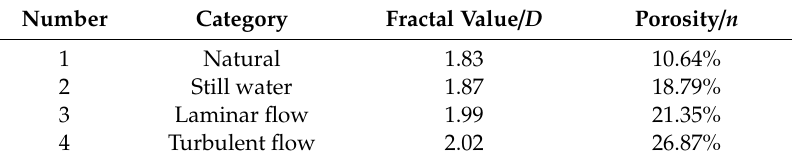
Table 3. Statistics of porosity and fractal dimension of soft rock after different flow patterns.